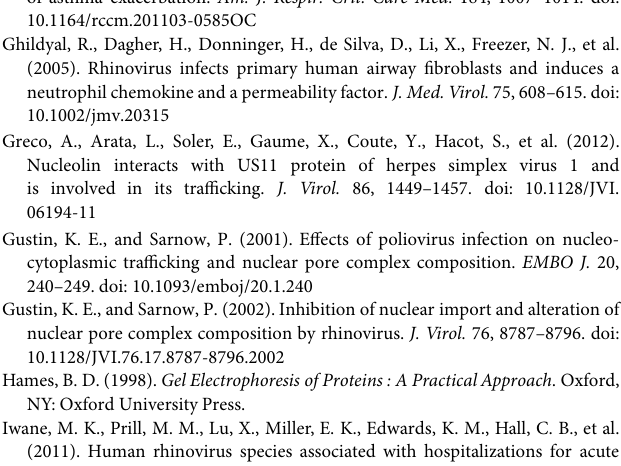
FIGURE S1 | Human rhinovirus effects in A549 cells. (A,B) A549 cells were infected without (mock) or with HRV2 or HRV16 (MOI of 5) for 24 h and cells lysed collected and subjected to Western analysis as described in Figure 1 . The approximate protein size (kDa) is shown on the left and the specificity of the antibodies is indicated on the right. Where cleavage products are observed, bands corresponding to full length proteins are indicated with arrowheads and cleavage products are indicated with brackets. cp – cleavage products. (C) A549 cells were grown on coverslips and infected without (mock) or with HRV2 or HRV16 (MOI of 5). At 24 h p.i. cells were fixed, permeabilized and probed with anti-dsRNA antibodies, followed by CF488 secondary antibodies. Coverslips were mounted in ProlongGold mounting media with DAPI. Fluorescence was imaged by CLSM (see Materials and Methods). FIGURE S2 | HRV2 and HRV16 replicate in A549 cells. Real-time PCR was used to assess the quantity of viral RNA present in infected cells at 24 h p.i. for HRV2 and HRV16 infection. Data is shown as arbitrary units relative to GAPDH. FIGURE S3 | Cell death after HRV2 or HRV16 infection. Ohio-HeLa cells were grown in six well plates and were mock infected, or infected with HRV2 or HRV16, at an MOI of 1. Live cells were imaged at 24 h p.i. using a Leica DMIL light